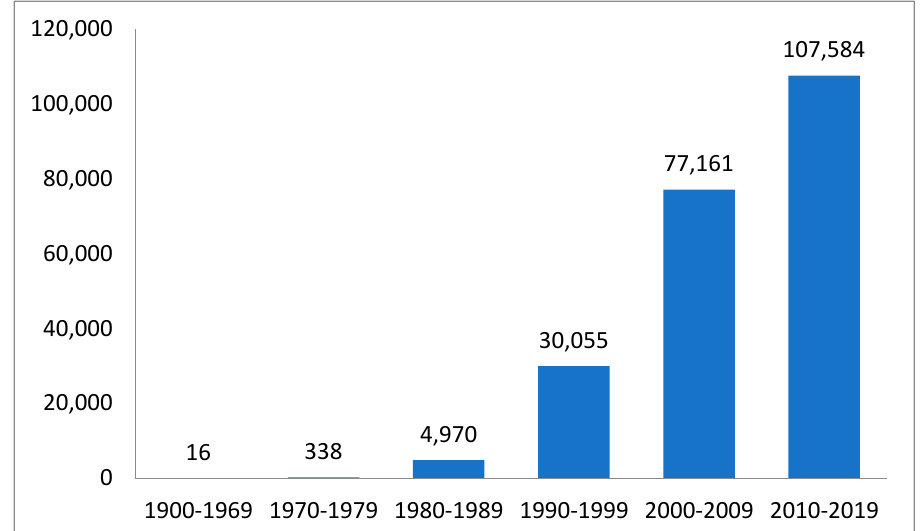
Figure 1. Technology transfer term frequency in PROQUEST.